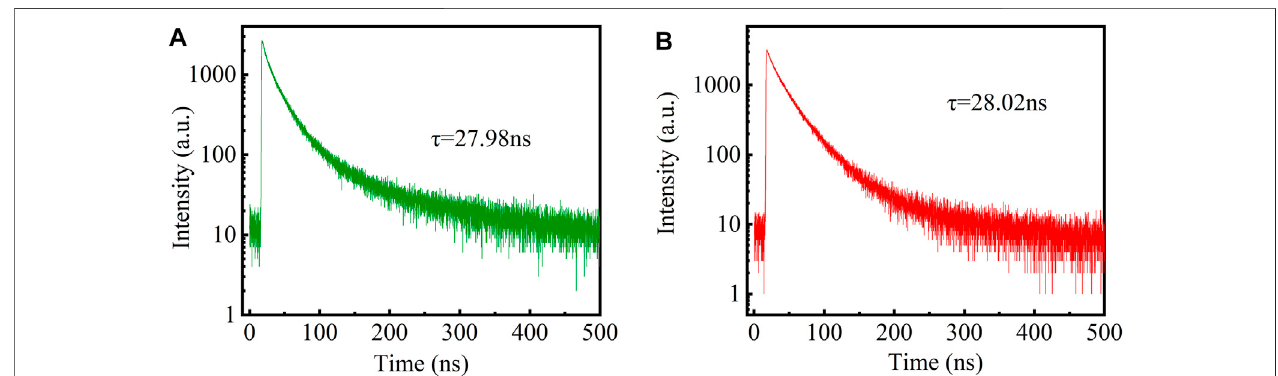
Frontiers in Chemistry |